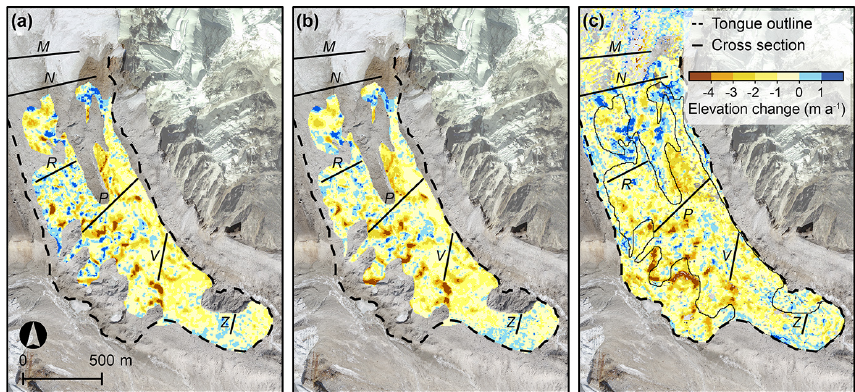
Figure 6. Elevation changes (ma − 1 ) for the periods (a) 2011–2014 (b) 2011–2015 and (c) 2009–2014 and from satellite imagery. The debris-covered tongue is outlined with a dashed